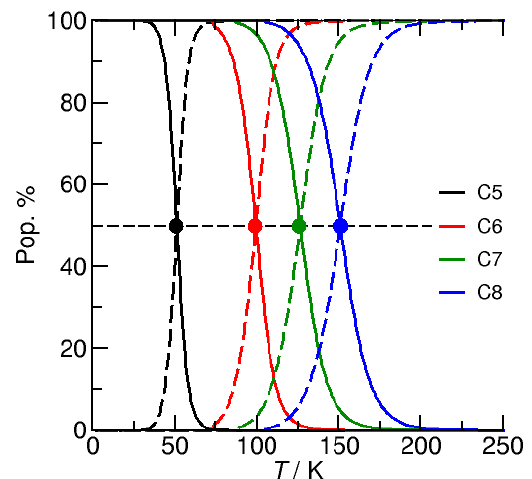
Figure 9. QCE-calculated cluster populations for cationic monomers (dashed lines) and dimers (straight lines) for species n = 5–8. Compared with the simple ideal gas approach, we now consider attractive interaction between the clusters’ species expressed by the mean-field parameter a mf . The filled circles indicate where the species are in the equilibrium ( Δ G =0 kJmol − 1 ). Here, we show the data for varying values a mf (from 0.04 to 0.1), which is equivalent to assuming the dispersion interaction between the species ranging from 1.2 to 3 kJmol − 1 , shifting the equilibrium to about 40 K higher temperatures.